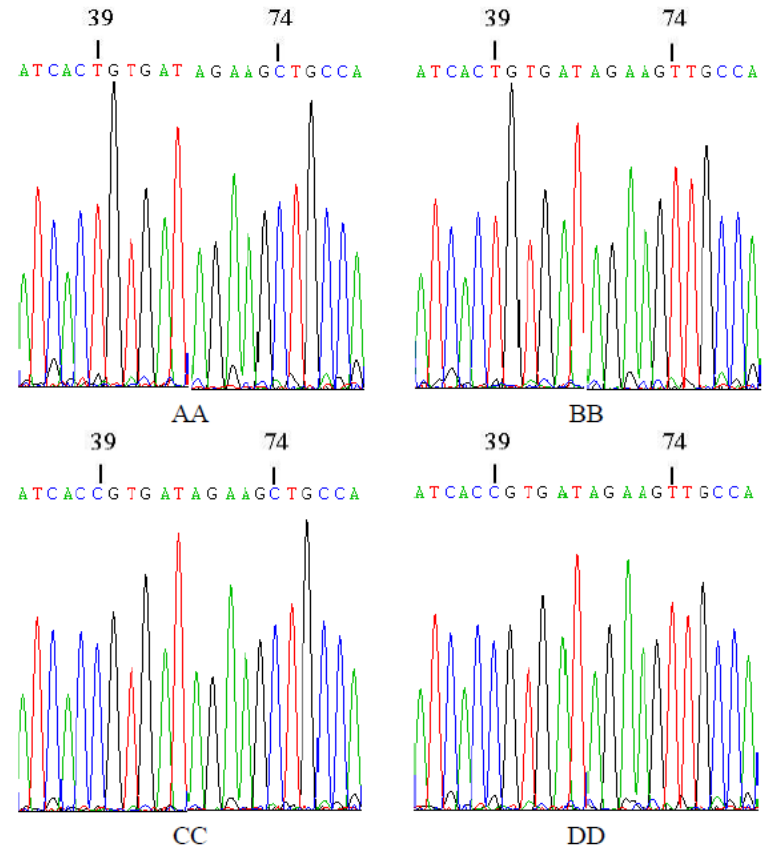
Figure 2. Mutation nucleotide sequence alignment of four homozygous genotypes.